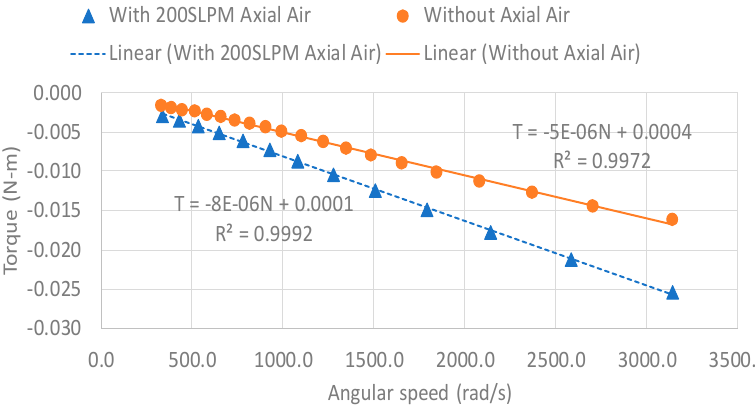
Figure 9. Torque versus speed spin down rest results.